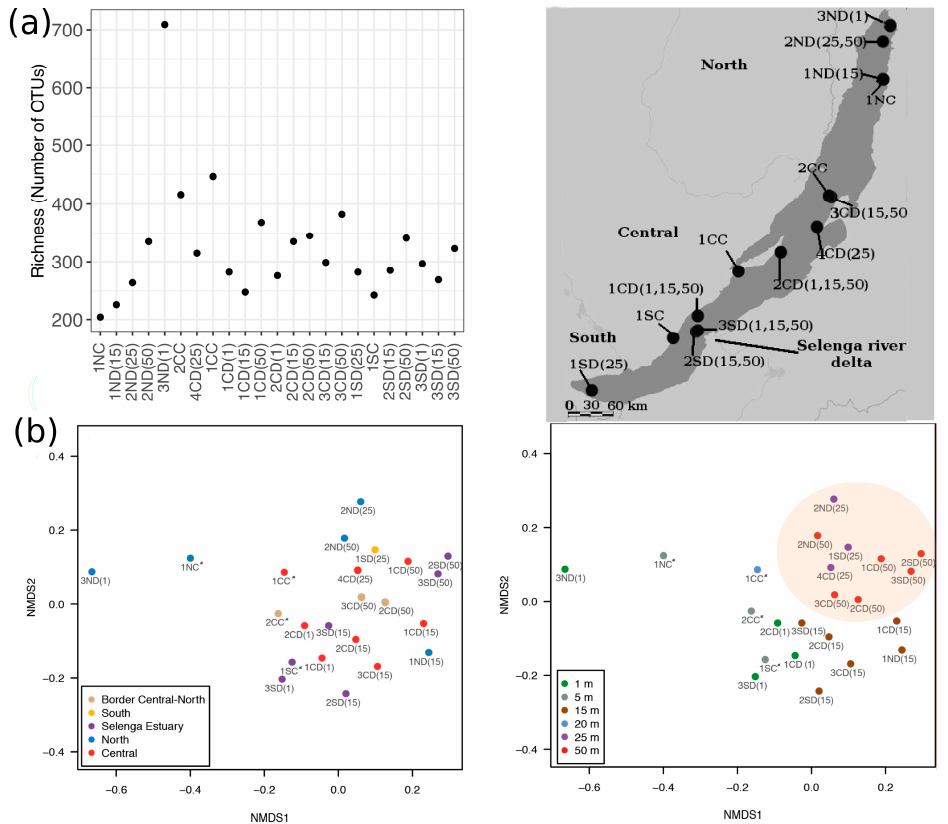
Figure 7. ( a ) OTUs richness in different samples (left) and the map, showing the location of the samples (right). ( b ) NMDS analyses indicating the variable composition of protist assemblages within different basins (left) and different depths (right). The orange oval on the right indicates samples from deeper waters (25 and 50 m). Coastal samples are marked with an asterisk. members of Bolidophycea, Pelagophycea, and Choanoflagellida were not found in two samples that